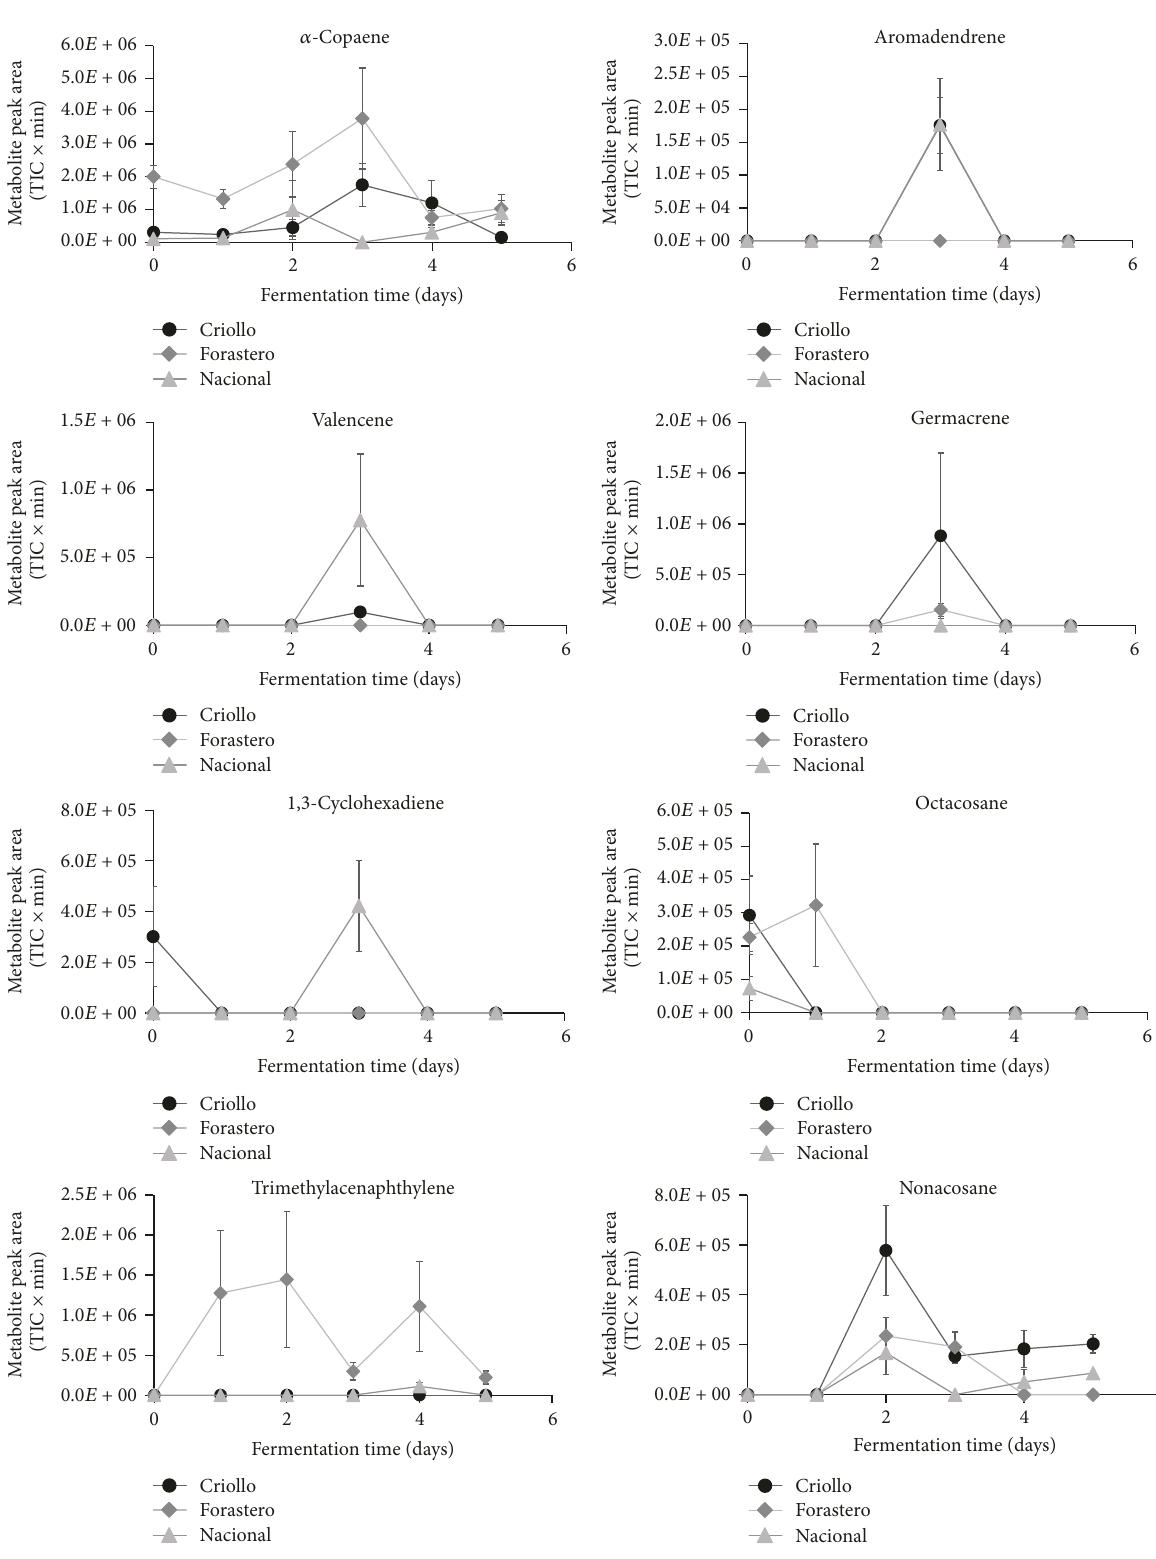
Figure 6: Levels of significant hydrocarbons in Criollo, Nacional, and Forastero beans at different fermentation times. Levels of each metabolite are presented as peak area (total ion current times the differential retention time for each metabolite in